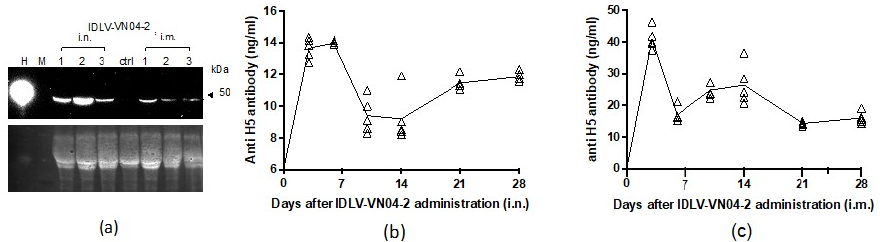
Figure 4. Temporal production of VN04-2 mAbs after IDLV-VN04-2 administration in vivo. ( a ) Presence of VN04-2 mAbs in the serum of individual mice ( n = 3) at 28 days after receiving IDLV-VN04-2 by the intranasal (i.n.) or intramuscular (i.m.) route (200 and 500 RT units, respectively) was measured by Western blot for human IgG. Mixed human sera (H, positive control), serum from an untreated mouse (ctrl, negative control), protein standard marker (M). All in all, 100 µg of total protein was loaded for each sample. Total unstained proteins (bottom) as loading control were visualized using the ChemiDoc MP system (Bio-Rad, Hercules, CA, USA). Groups of 5 mice received ( b ) i.n. or ( c ) i.m. administration of IDLV-VN04-2 (250 and 500 RT units, respectively). Levels of serum anti-H5 antibodies before or at 3, 6, 9, 14, 21 and 28 days after IDLV-VN04-2 administration were measured by ELISA. Triangles represent individual mice; lines indicate mean